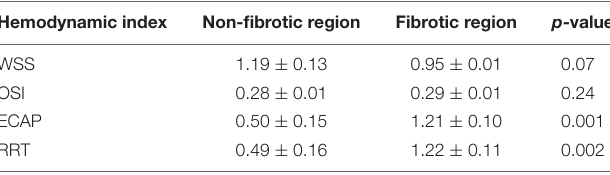
TABLE 2 | Comparison of hemodynamics in normal and fibrotic regions averaged across eight